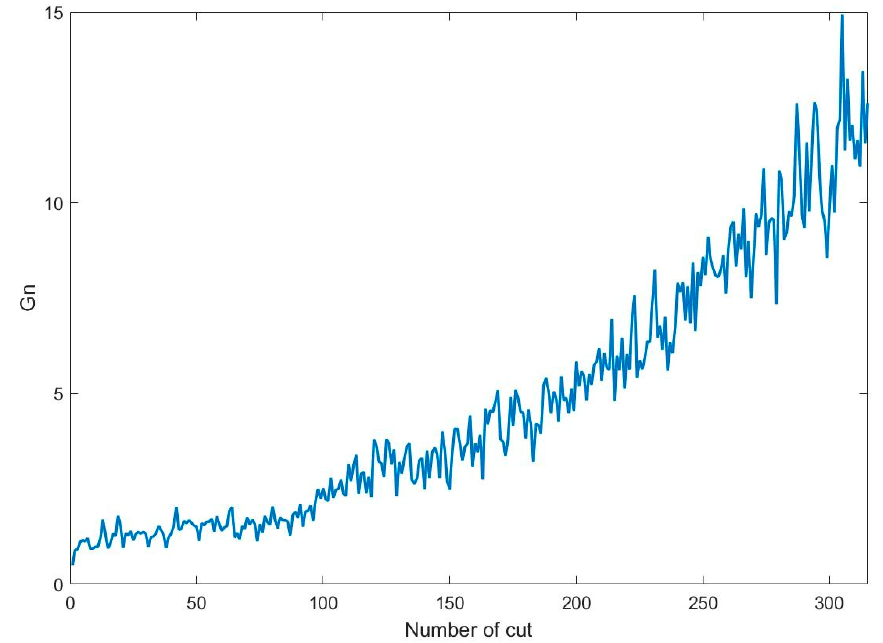
Figure 3. Time ‐ dependent trend chart for Gn of vibration signals in the milling process. Figure 3. Time-dependent trend chart for Gn of vibration signals in the milling